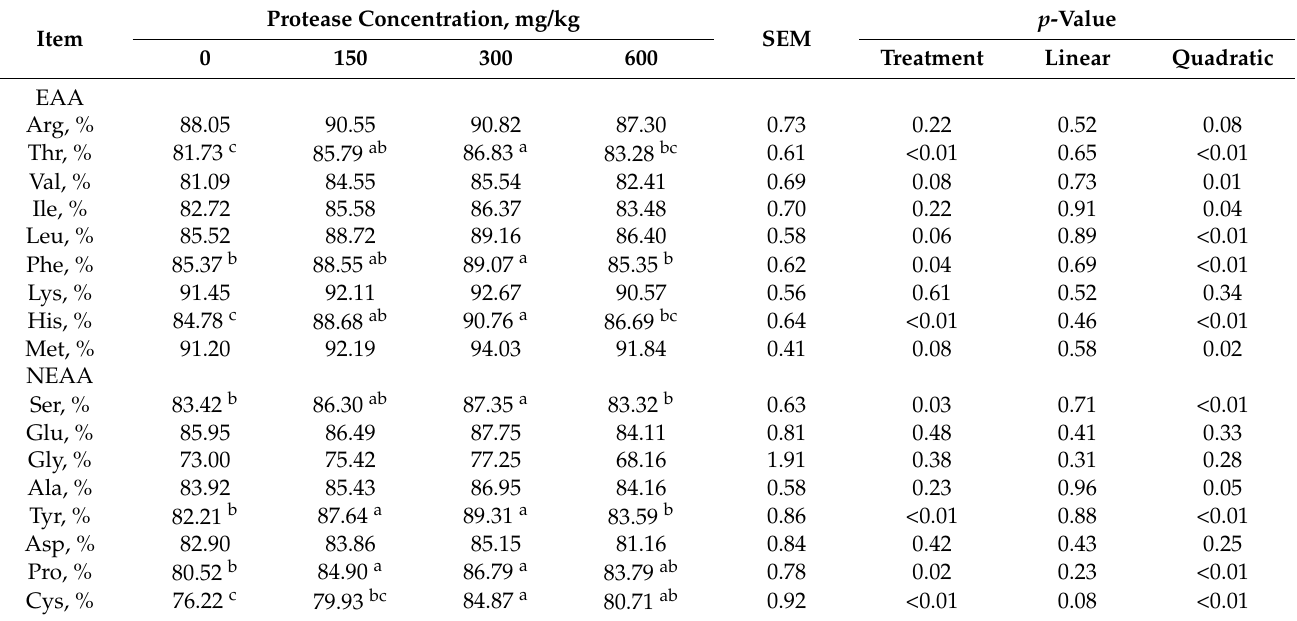
Table 6. Effects of protease supplementation on apparent ileal digestibility of amino acids in weaned